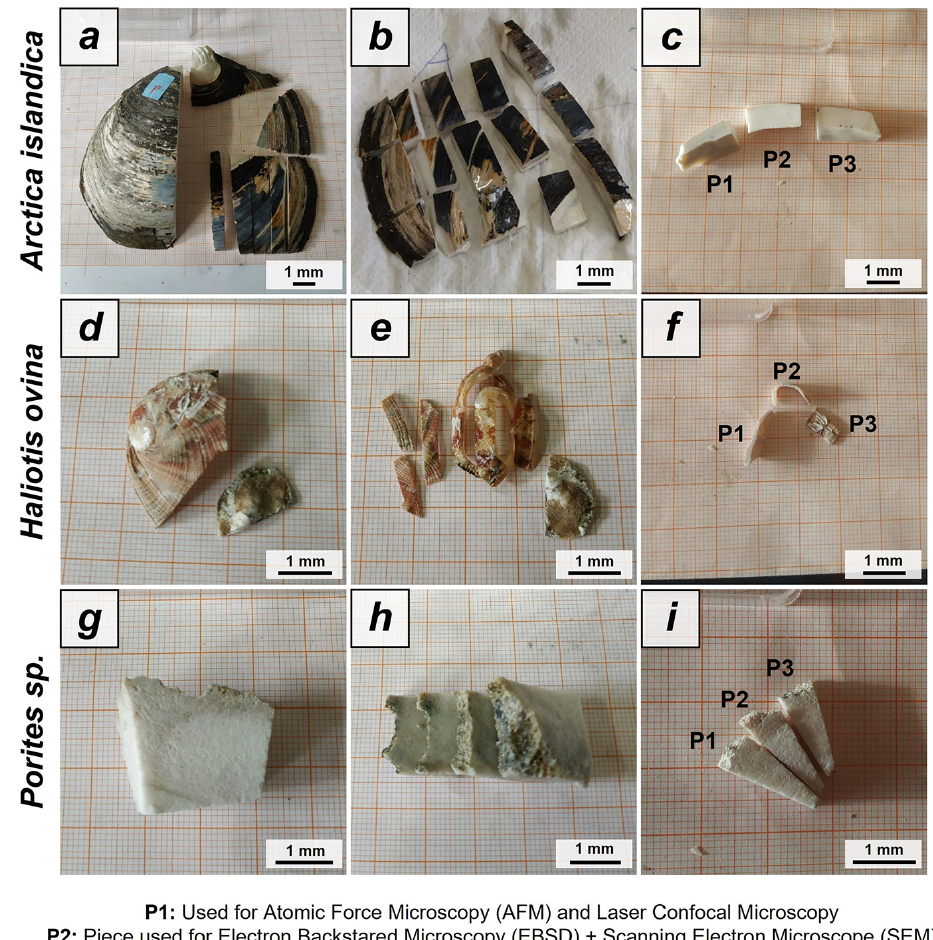
Figure A1. Preparation of Arctica islandica , Haliotis ovina shells and Porites sp. skeletons for hydrothermal alteration experiments. A long section was cut out of the hard tissue (a, d, g) . Subsequently, it was sectioned into three parts: P1, P2 and P3 (b, e, h) . The pieces were then altered. P1 was used for laser confocal microscopy and atomic force microscopy (AFM) imaging, P2 was used for FE-SEM imaging and EBSD measurements, and P3 was powdered and used for XRD and TGA measurements; the XRD data formed the basis for Rietveld